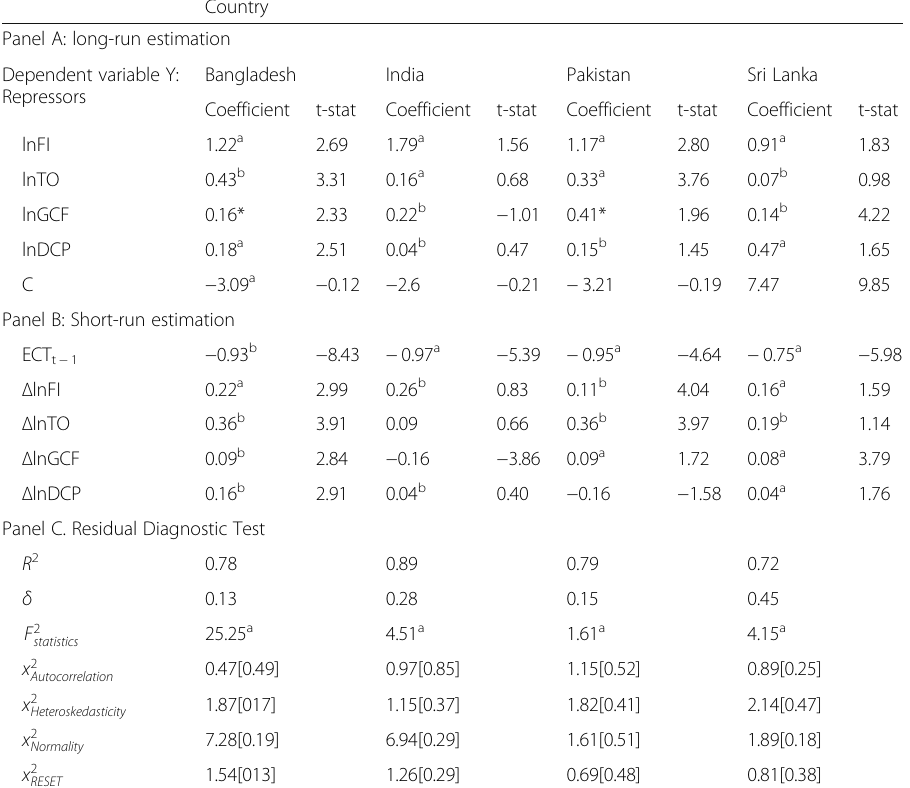
Table 4 Long-run and short-run coefficients under ARDL Country Panel A: long-run estimation Dependent variable Y: Repressors